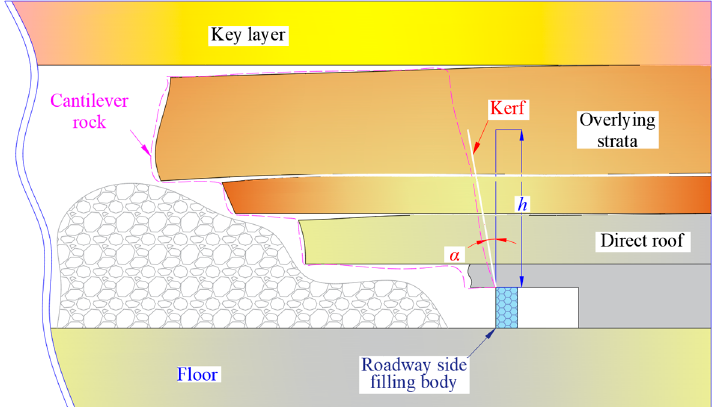
Figure 12. Cantilever beam structure. The caving and the fracture zones appear from bottom to top after mining coal seams.